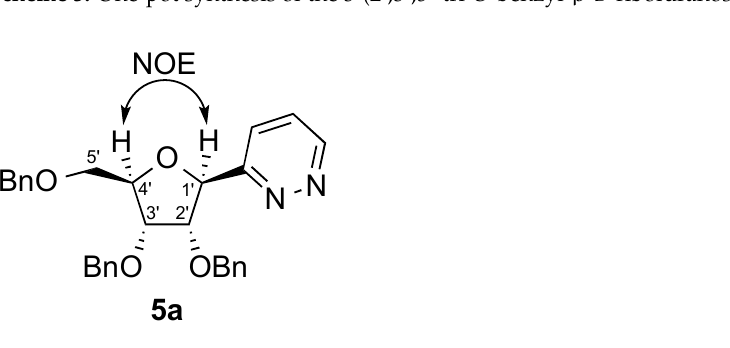
Scheme 3. One-pot synthesis of the 3-(2 (cid:48) ,3 (cid:48) ,5 (cid:48) -tri- O -benzyl- β - D -ribofuranosyl)pyridazine ( 5a ).